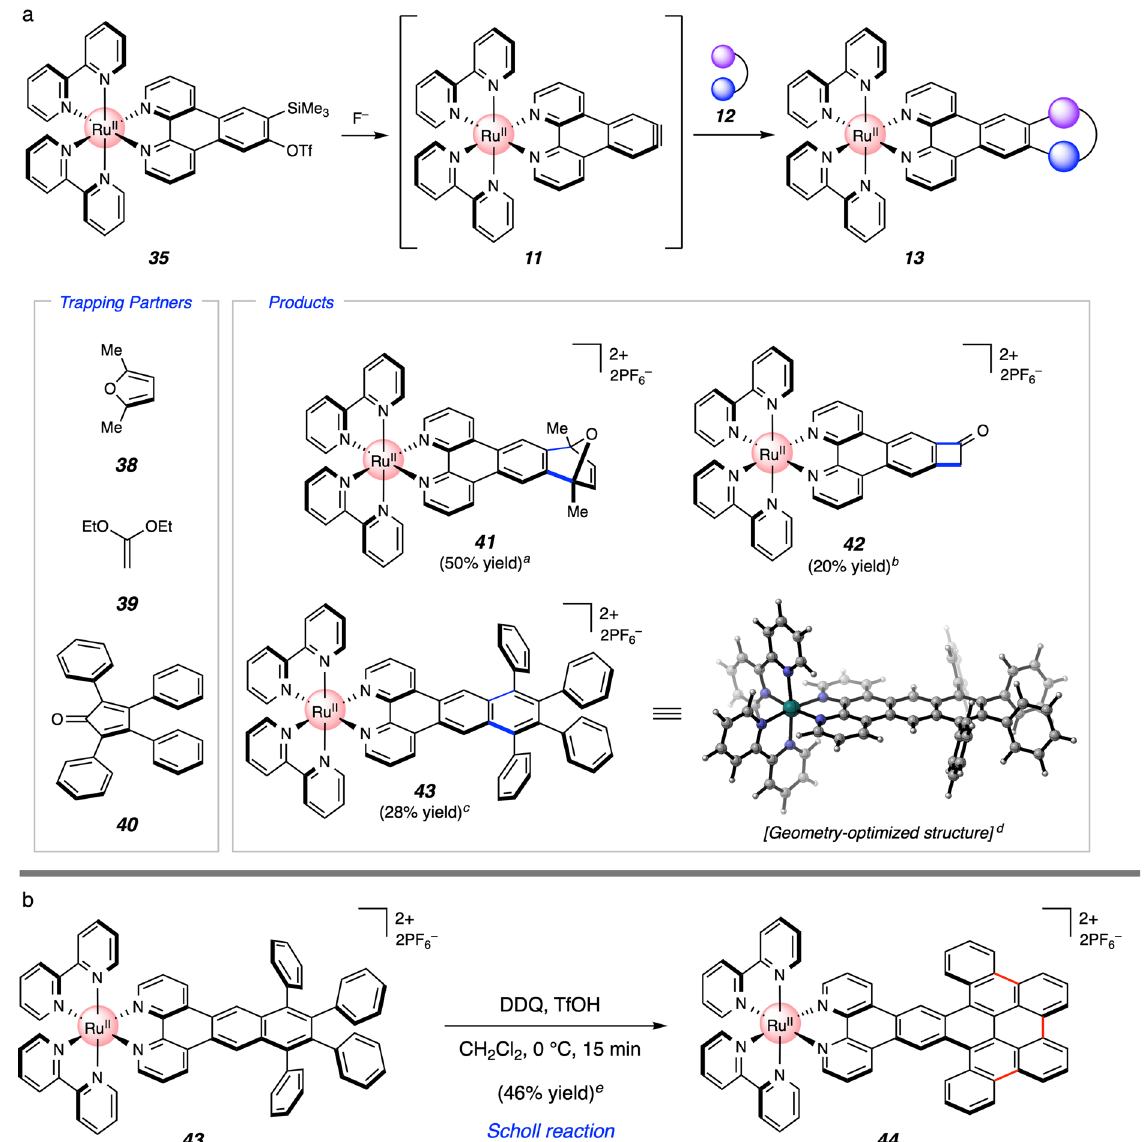
Fig. 8 Mild generation and trapping of a Ru(II) aryne. a Cycloaddition reactions of organometallic aryne 11 . b Scholl reaction of 43 to give 44 . a Conditions: 35 (1 equiv), 38 (10 equiv), CsF (5 equiv), CH b Conditions: 35 (1 equiv), 39 (5 equiv), CsF (3 equiv), CH 3 CN, 23 °C, 12 h. 3 CN, 23 °C, 1.5 h; TFA. c Conditions: 35 (1 equiv), 40 (2 equiv), CsF (5 equiv), CH 3 CN:CH 2 Cl 2 (2:1), 50 °C, 1.5 h. d Geometry optimization of 43 (without counterions) was performed using B3LYP/6-31 G(d)/LANL2DZ/CPCM(MeCN). e Conditions: 43 (1 equiv), DDQ (20 equiv), CH 2 Cl 2 :TfOH (40:1), 0 °C, 15 min. OTf, tri fl uoromethanesulfonate; Me, methyl; Et, ethyl; DDQ,